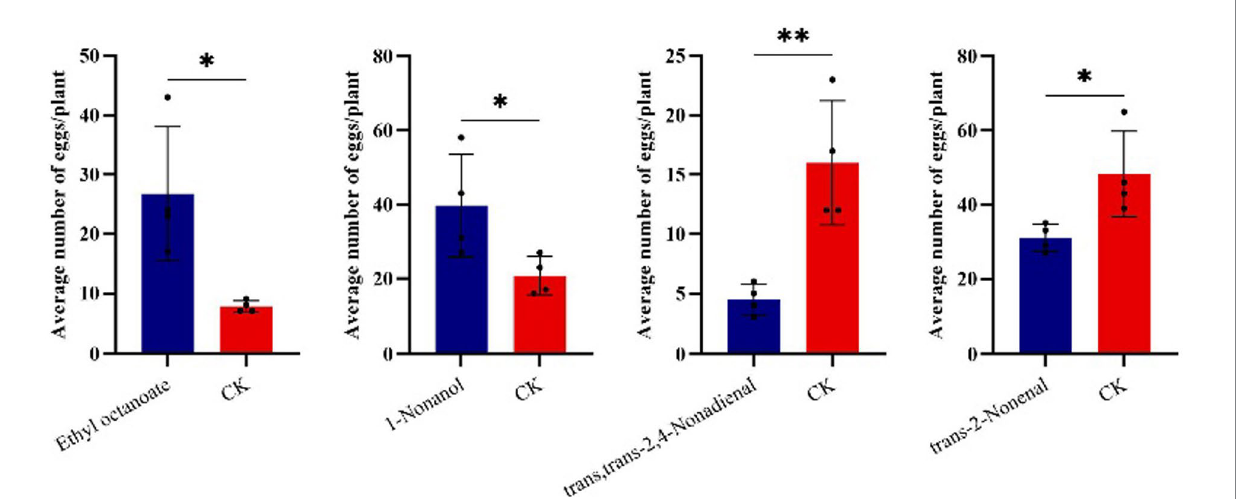
FIGURE 4 The effect of four VOCs on the oviposition behavior of T. absoluta . The bar represents the standard error, and asterisks indicate significant differences (* p < 0.05; ** p <